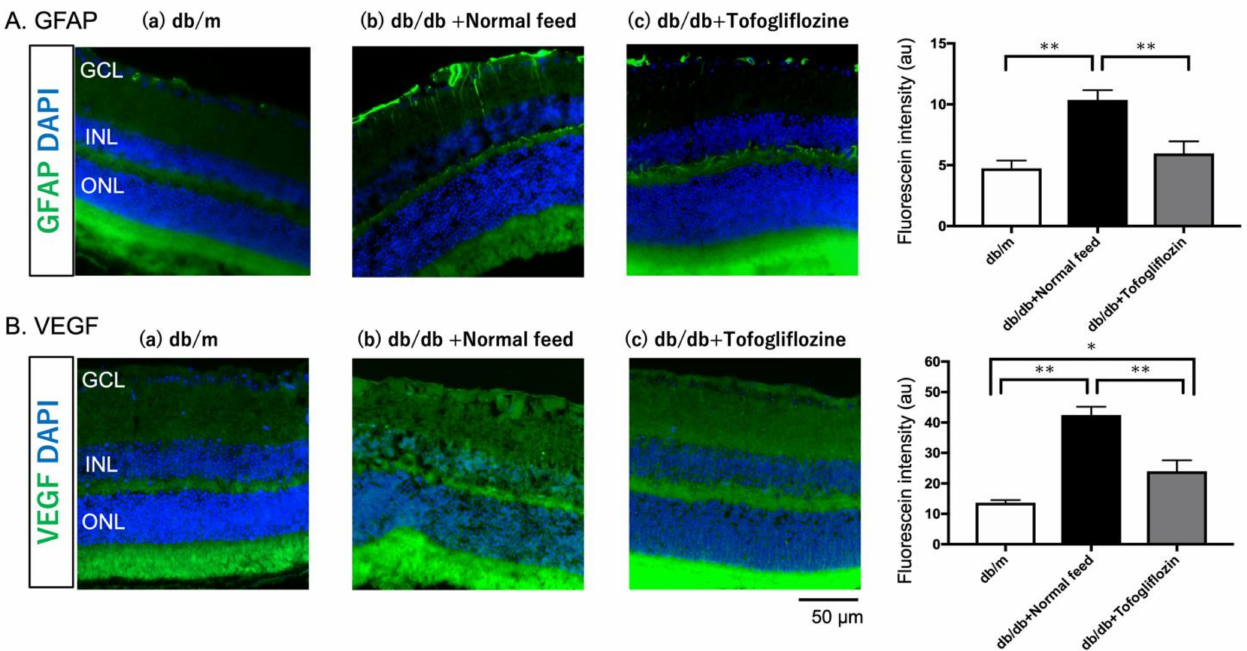
Figure 7. Effect of SGLT2i tofogliflozin on the glial activation ( A ) and production of VEGF ( B ). Comparison of GFAP immunofluorescence (green) between representative samples from in db/m ( a ) and untreated ( b ) or SGLT2i-treated ( c ) db/db mice at 14 weeks. In the diabetic retina with normal feed ( b ), the end-feet of the Müller cells show abundant GFAP immunofluorescence, and the radial processes are stained intensely throughout both the inner and outer retina. In the diabetic retina with tofogliflozin ( b ), the immunofluorescence of both GFAP and VEGF was reduced and comparable with that in db/m control mice ( a ). There were significant differences in the fluorescein intensities of GFAP ( p = 0.005) and VEGF ( p < 0.0001) among the three groups by one-way ANOVA. There were significant increases in intensities of GFAP and VEGF in the untreated db/db mice ( n = 6), compared with the non-diabetic db/m mice ( n = 5). These increases were significantly ameliorated in the tofogliflozin-treated murine retina ( n = 6). * p < 0.05, ** p < 0.01. Nuclei were labeled with DAPI (blue). ONL, outer nuclear layer; INL, inner nuclear layer; GCL, ganglion cell layer. Scale bar = 50 µ